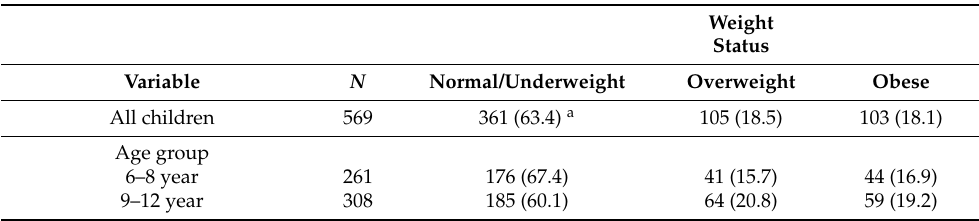
Table 4. The relationship of weight status with sociodemographic factors, caries experience, medical history, and food intake frequency among